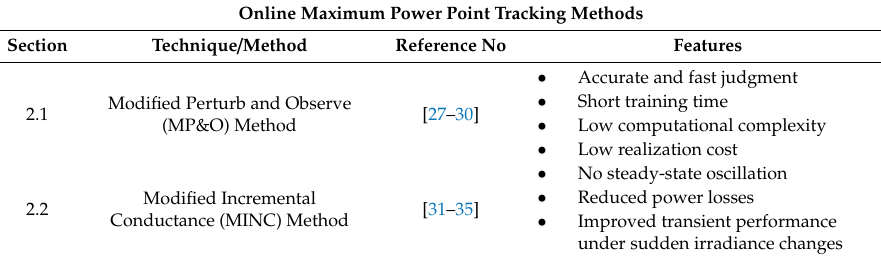
Table 4. Features of online maximum power point tracking